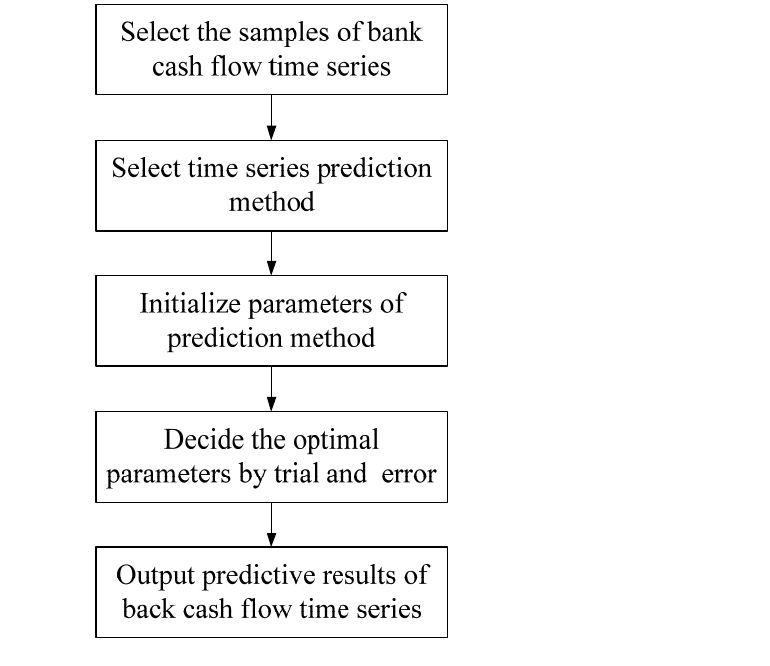
Figure 1. Flowchart of the time series prediction methods of bank cash